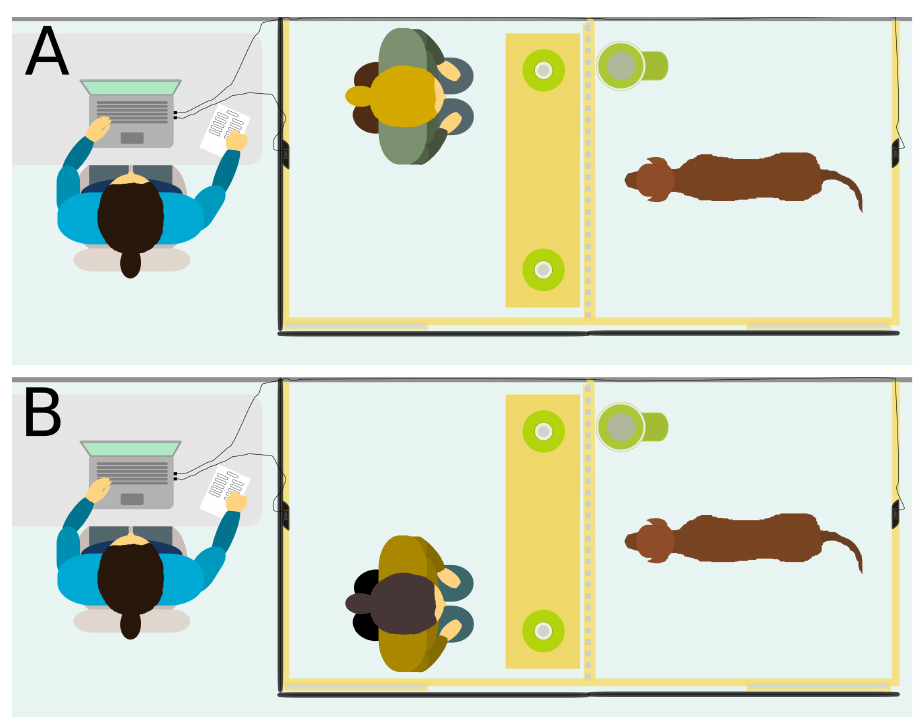
Fig 3. Experience phase session with the helpful human (A) and with the unhelpful human (B). With the exception of the first two trials of the experience phase, the helpful human knelt in front of the functional button, which was adjacent to the food dispenser, and pressed this button on each trial, thereby releasing food for the subject. With the exception of the first two trials, the unhelpful human knelt in front of the non-functional button and pressed this on each trial resulting in no food being released for the